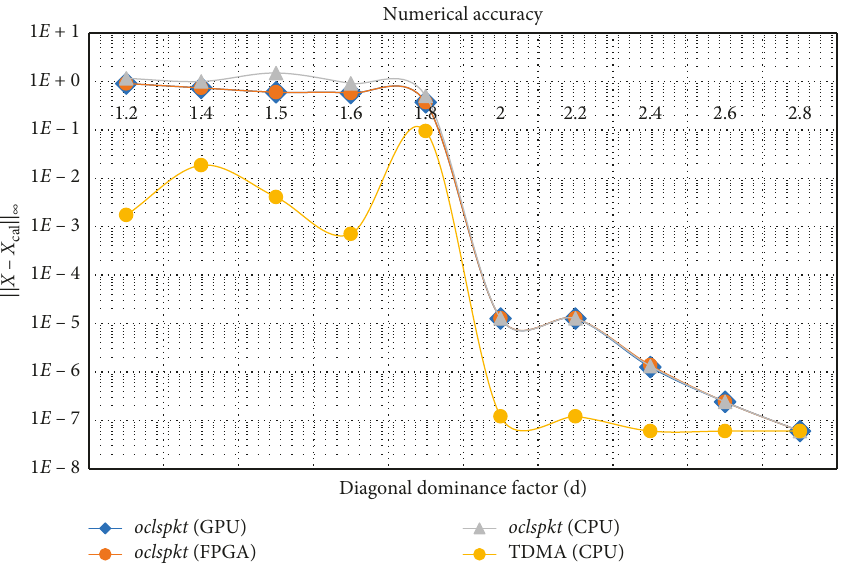
Figure 9: Numerical accuracy of oclspkt for varying diagonal dominance compared to CPU TDMA